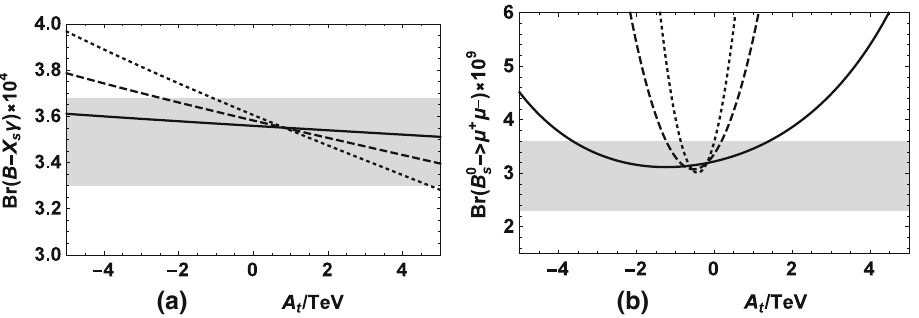
Fig. 5 Br ( ¯ B → X s γ) ( a ) and Br ( B 0 s → μ + μ − ) ( b ) versus A t for tan β = 5 ( solid line ), tan β = 20 ( dashed line ), tan β = 35 ( dotted line ) , when m ˜ t = 1 . 6TeV , M H ± = 1 . 5TeV. The gray area denotes the experimental 1 σ interval